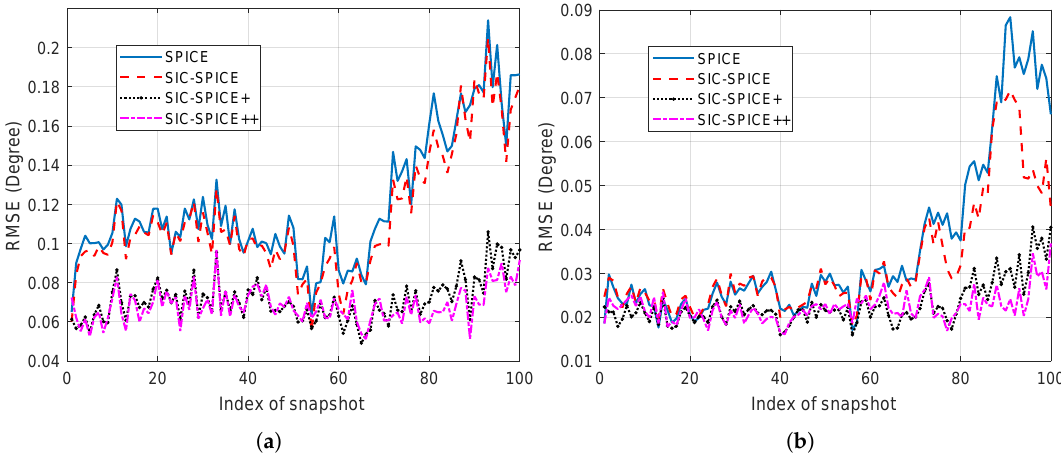
Figure 2. RMSE of different algorithms versus snapshot with N = 20, K = 10 N , and SNR = 20 dB. ( a ) RMSE of the first source ( b ) RMSE of the third source.